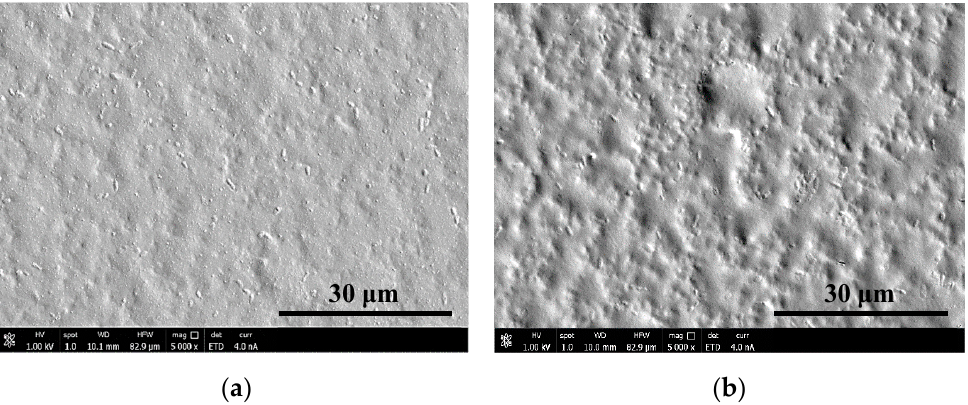
Figure 1. Scanning electron microscopy (SEM) images of nanoparticles distribution: (a) silver nanoparticles and (b) reduced graphene oxide flakes in chitosan/chondroitin sulfate (Chi/CS) film.